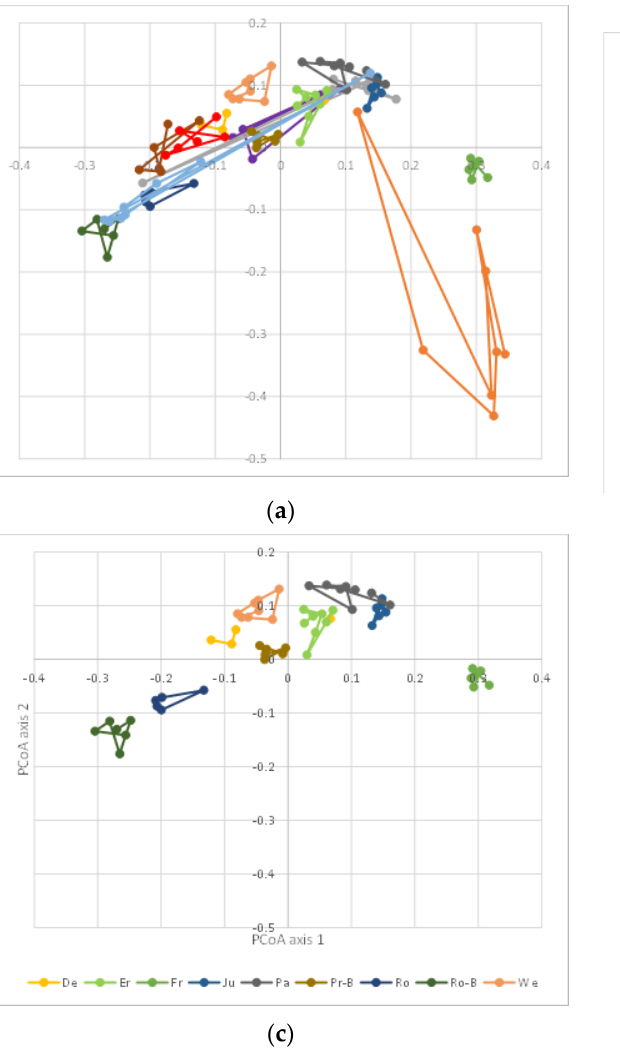
Figure 4. Two first axes of the unweighted PCoA (similar to Figure 1a) for all individuals ( a ); two first axes of the unweighted PCoA for those individuals with relatively large changes ( b ); two first axes of the unweighted PCoA for those individuals with more resilient microbiota ( c ). Samples are color-coded according to the different individuals (see legends of ( b , c )). Axis 1 explains 18.9% and axis 2 8.5% of the variability between samples, respectively.